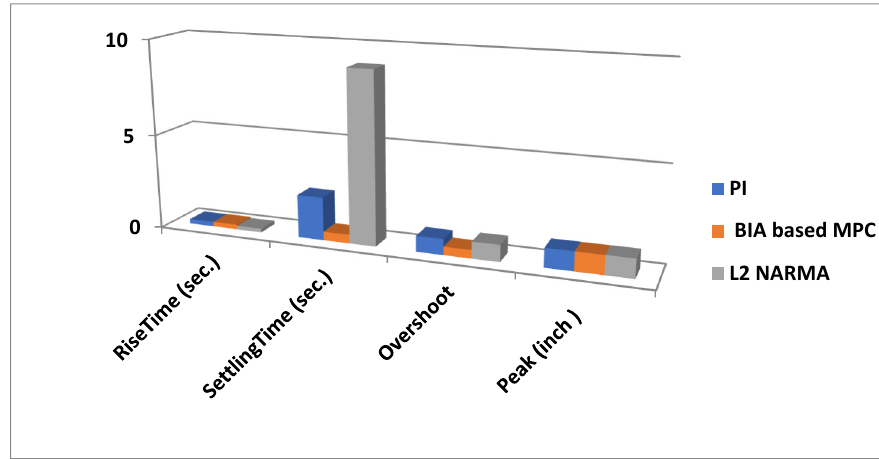
Figure 11. Chart of performance criteria in the nominal case.